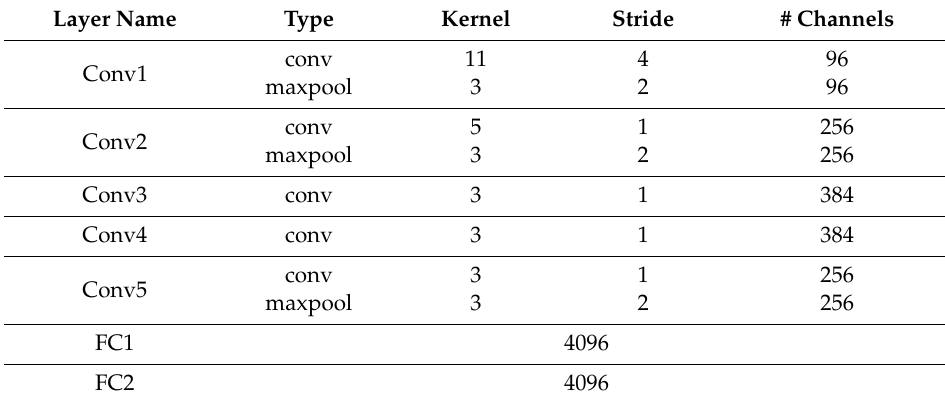
Table 1. Configuration of teacher network using AlexNet. Each convolutional layer and fully connected layer was followed by ReLU, which is not shown in the table for brevity.